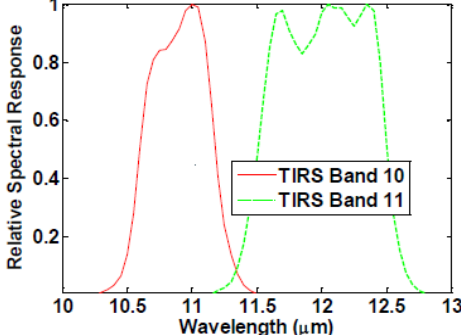
Figure 3. Landsat-8 TIRS bands’ relative spectral response functions (the data can be seen